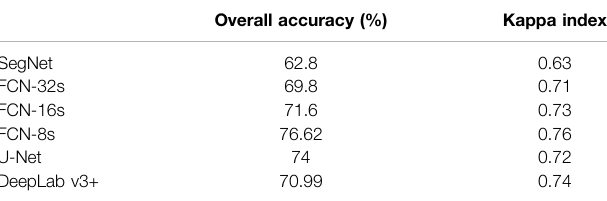
TABLE 4 | Overall accuracy and kappa index for the classi fi ers.